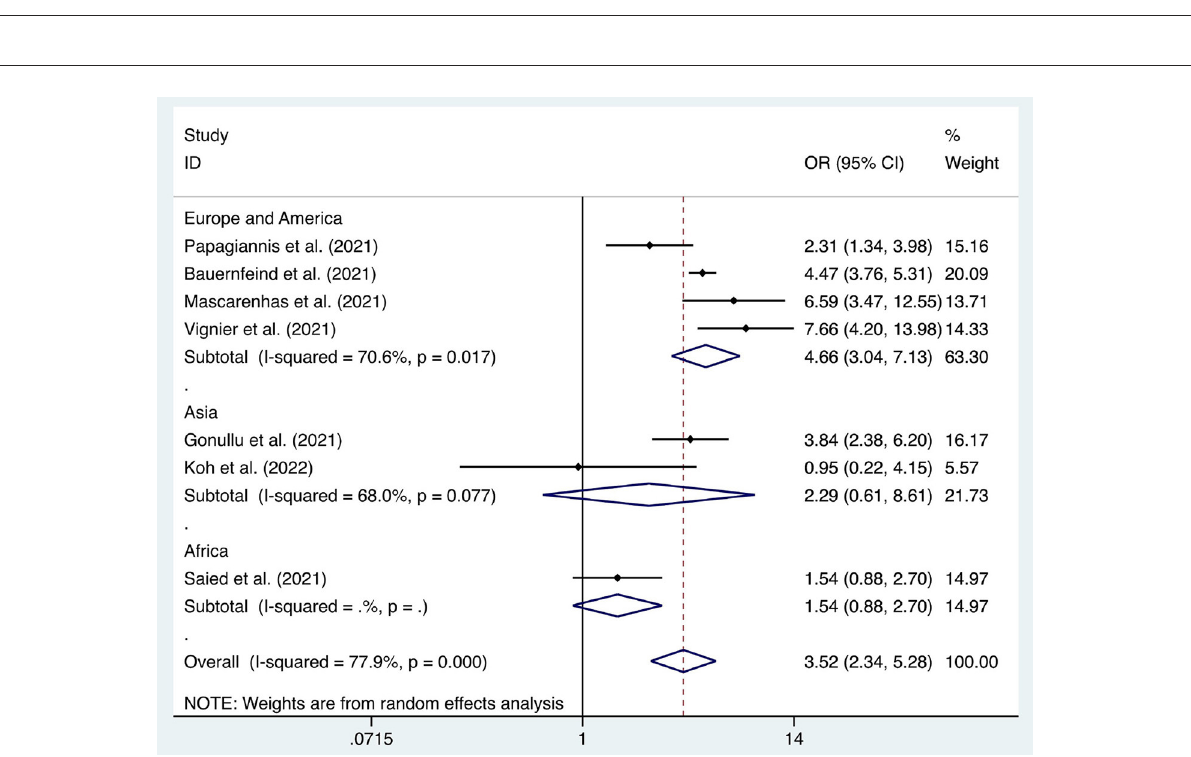
FIGURE9 Forest plot of the acceptance of seasonal influenza vaccines by healthcare workers